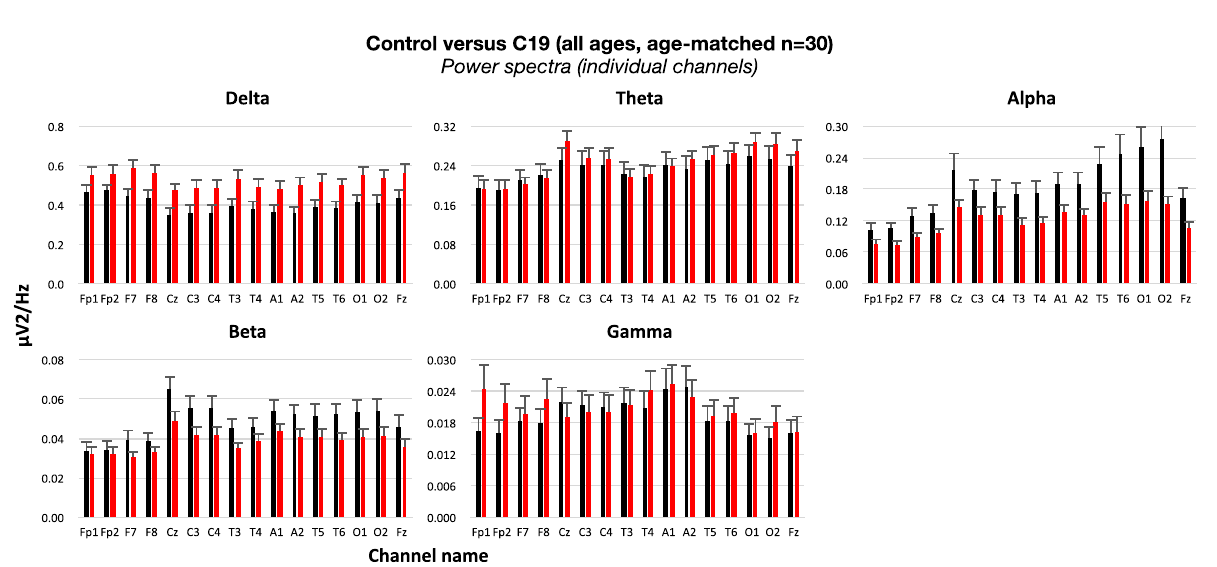
Figure 2. Power spectral density in 16 individual EEG channels in age-matched control and C19 subjects (n = 30 per group) in the frequency bands delta (1–4 Hz), theta (5–9 Hz), alpha (10–13 Hz), beta (14–32 Hz) and low gamma (33–52 Hz). No statistically significant difference was noted between groups in any individual